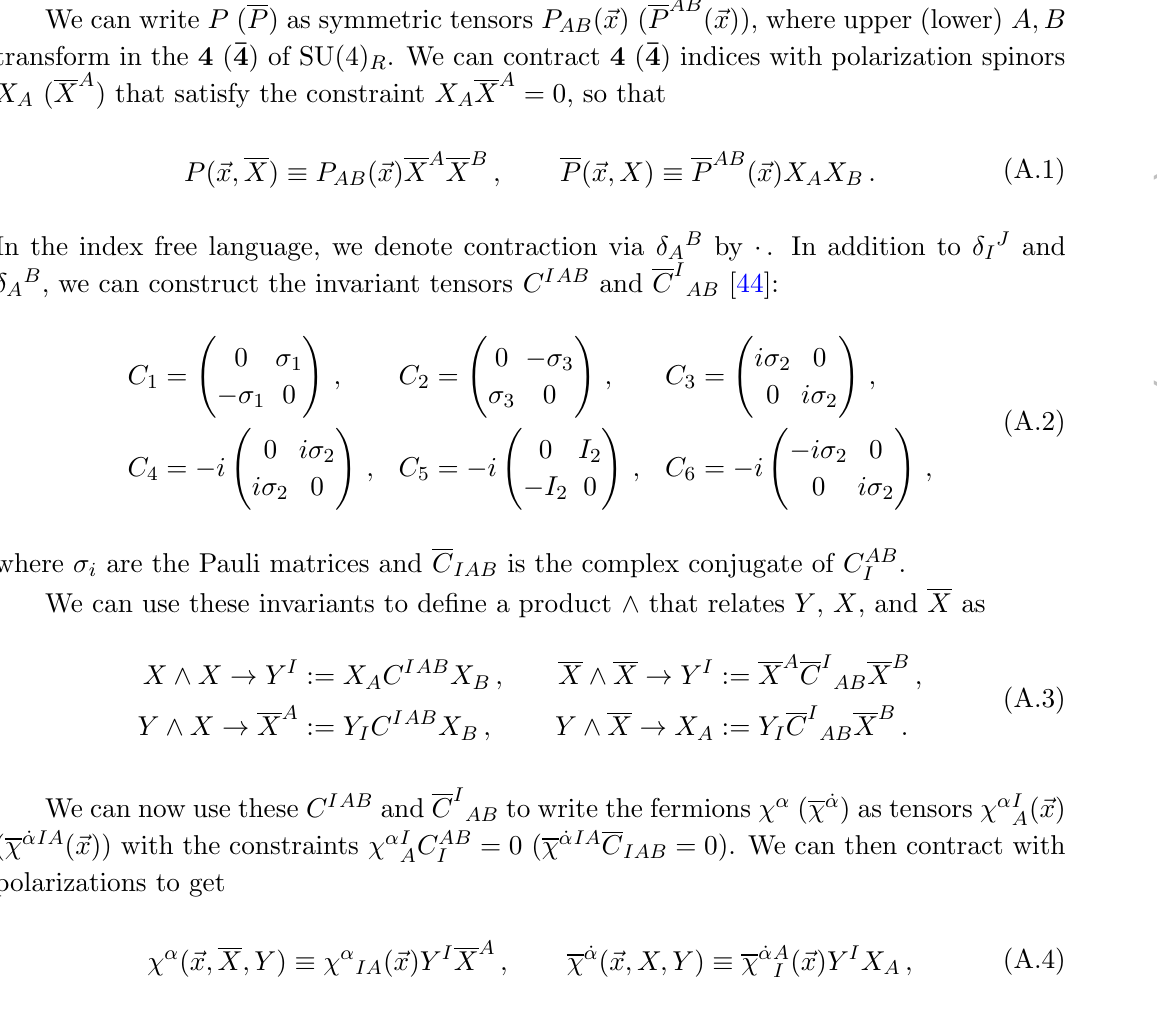
Table 1 . Operators in the N = 4 stress energy tensor multiplet and their scaling dimensions (cid:1), spins [ j; j 0 ] of the Euclidean Lorentz group SO(4) (cid:24) = SU(2) (cid:2) SU(2), irreps of the R -symmetry group SU(4) R , and charges of the bonus symmetry group U(1) B . _ (cid:11) _ (cid:12) dimension 3 complex two-form F (cid:11)(cid:12) ( F ) in the [0 1 0], and the dimension 3 R -symmetry current j (cid:22) in the adjoint [1 0